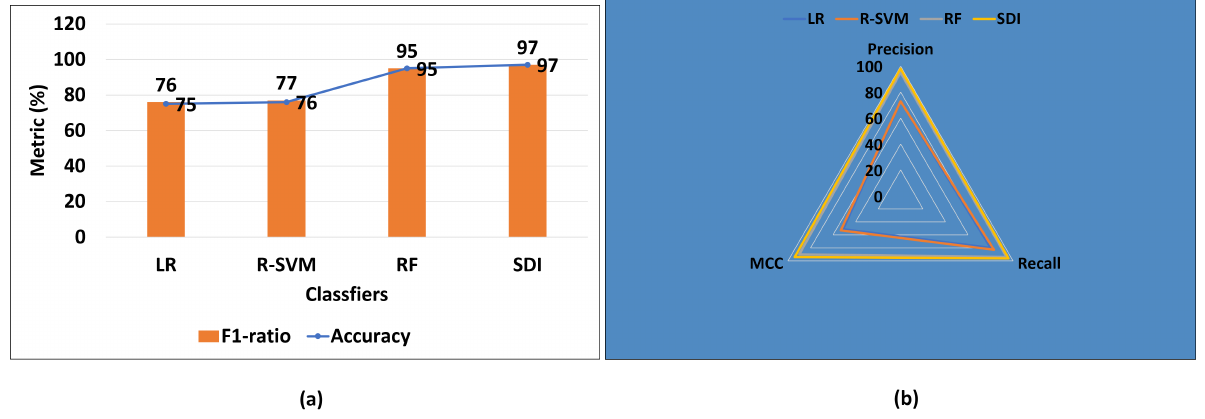
Figure 8. SDI comparison with existing algorithms to identify course.